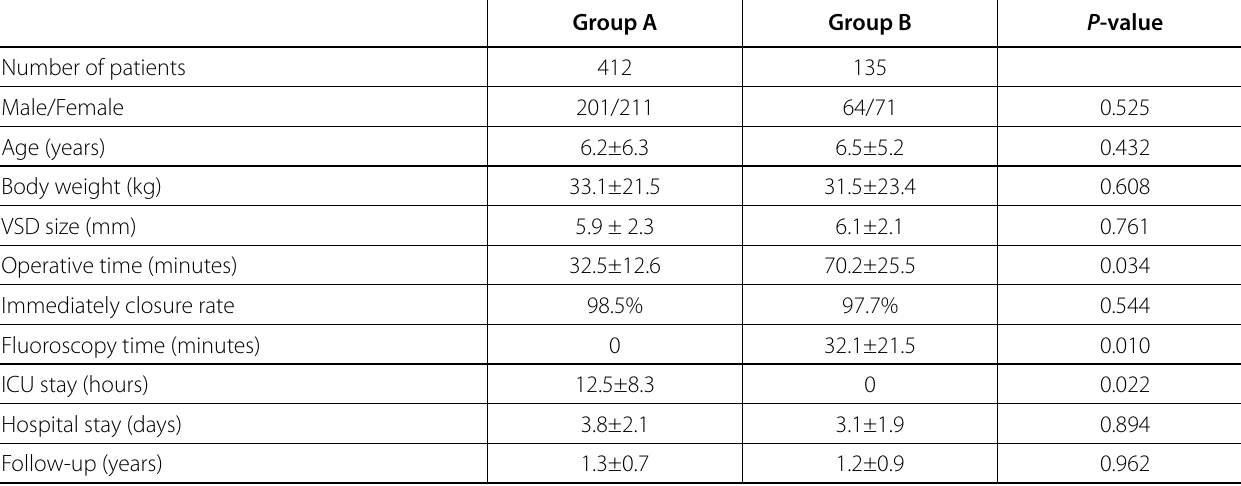
Table 1 . Comparison of clinical data between both groups (successful closure